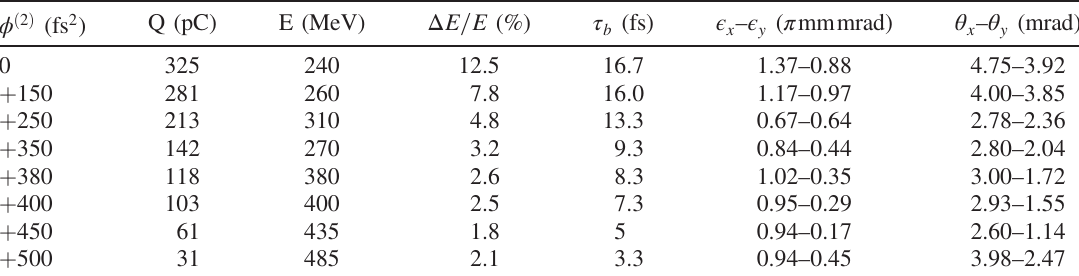
TABLE I. Tabulation of electron bunch energy (E), energy spread ( Δ E=E %), injected bunch charge (Q), bunch duration, transverse normalized rms emittance ( ϵ x − ϵ y ), and divergence ( θ x − θ y ) with respect to the group delay dispersion ( ϕ ð 2 Þ ) of a laser pulse. The electron beam parameters are reported around z ≈ 3 . 9 mm distance traveled by a laser pulse in a